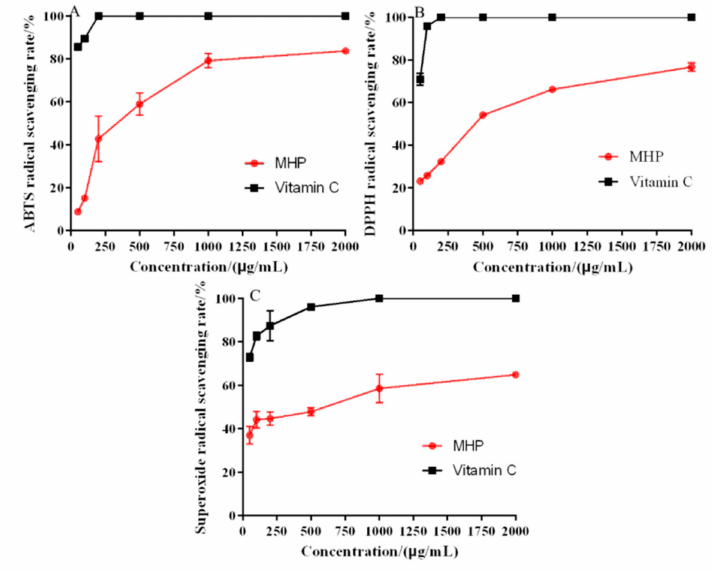
Figure 4. In vitro antioxidant activity: the scavenging rate of ABTS ( A ), DPPH ( B ), and superoxide radical ( C